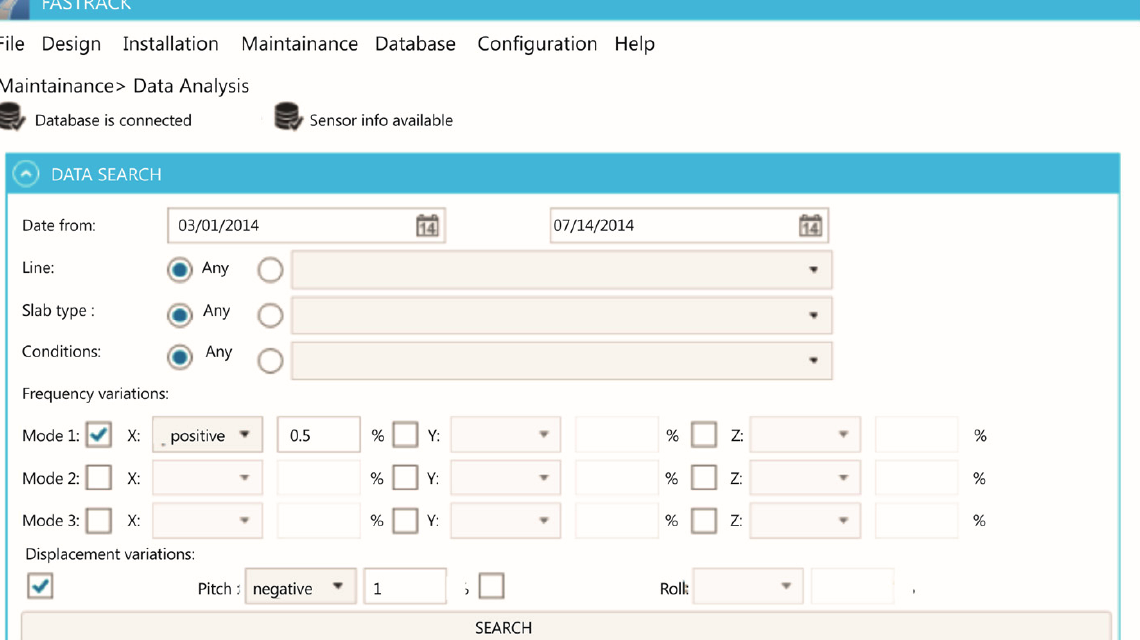
Figure 4. Control Center: Data